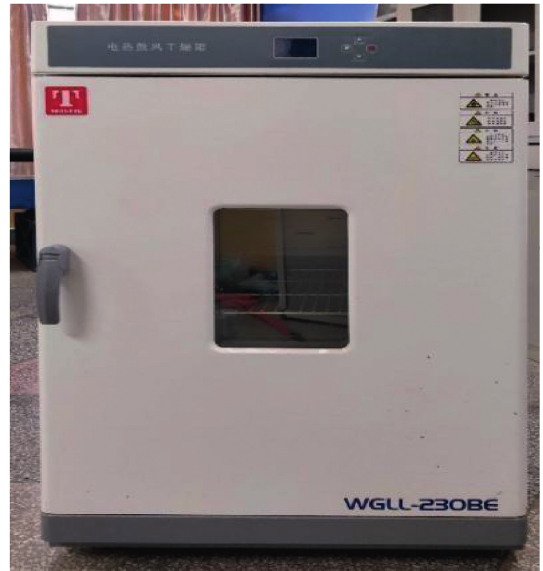
Figure 2: Electric heating blast drying